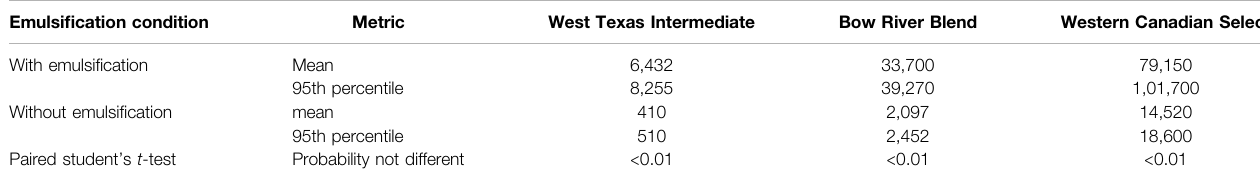
TABLE 3 | Expected viscosity (cP) of weathered fl oating oil for a surface release of 200 MT, based on results for 114 simulations varying spill